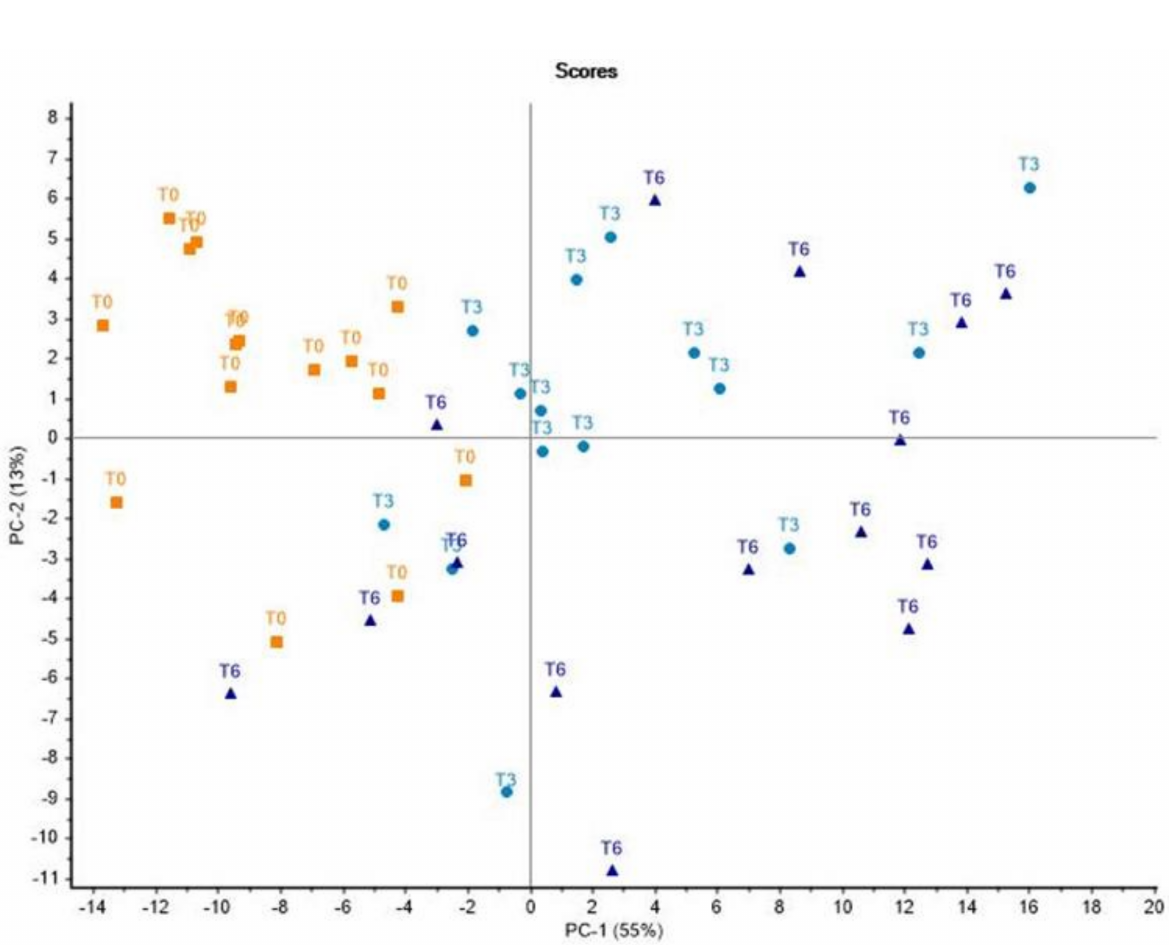
Figure 1. Projection of the samples onto the space defined by the first two principal components (PC1/PC2). Montanera Iberian dry-cured lomito samples were grouped according to pre-cure freezing effect (dry-cured lomitos ; T0, and pre-frozen dry-cured lomitos ; T3 and T6). (-) NaCl, (-) a* , (-) b* , (-) springiness, (-) cohesiveness, (-) resilience, (-) C16:1, (-) C18:1 n-9, (-) C18:2 n-6, (-) C18:2 n-3, DM, IMF, WL, L* , α - and γ -tocopherol, lipid and protein oxidation, WBSF, hardness, chewiness, C16:0, C18:0 (PC1). (-) α - and (-) γ -tocopherol, (-) lipid and (-) protein oxidation, (-) WBSF, (-) hardness, (-) springiness, (-) cohesiveness, (-) chewiness, (-) resilience, (-) C16:1, (-) C18:1 n-9, DM, IMF, NaCL, WL, L* , a* , b* , C16:0, C18:0, C18:2 n-6, C18:3 n-3 (PC2). T0: Montanera Iberian dry-cured lomitos manufactured from non-frozen Iberian presas , T3 and T6: Montanera Iberian pre-frozen dry-cured lomitos, manufactured from frozen during 3 and 6 months, respectively, and thawed Iberian presas